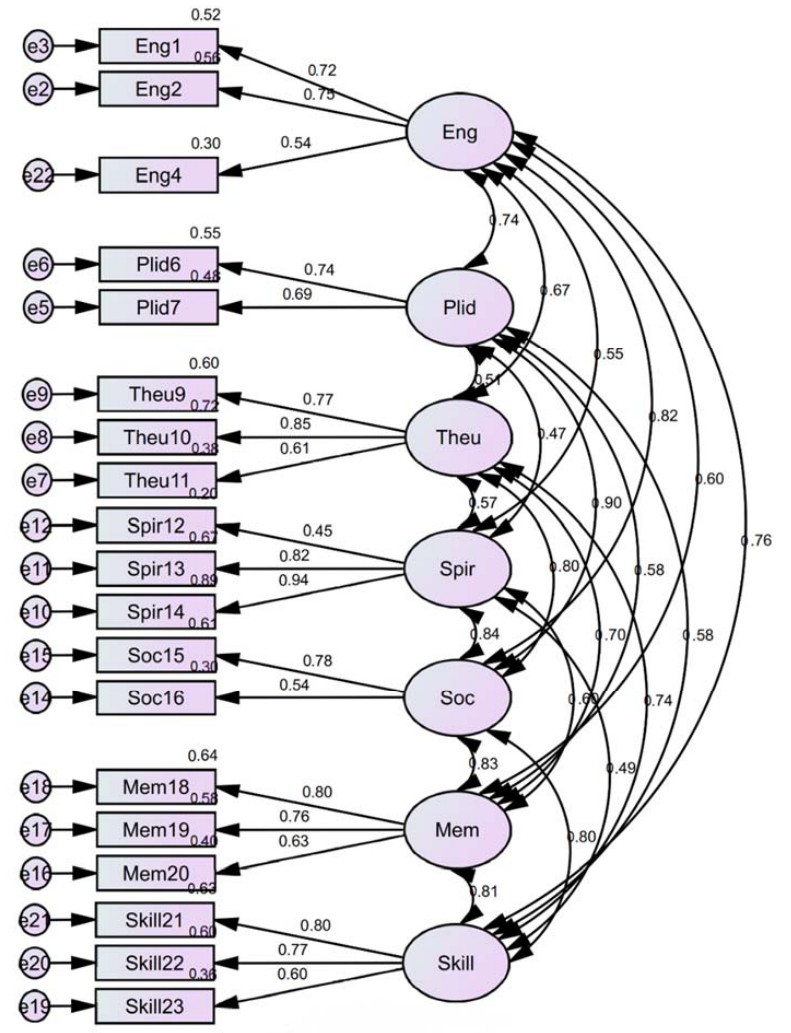
Figure 10. Structure of Model E1 using CFA analysis.